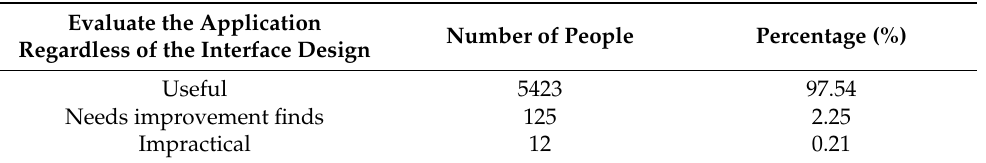
Table 7. User satisfaction survey